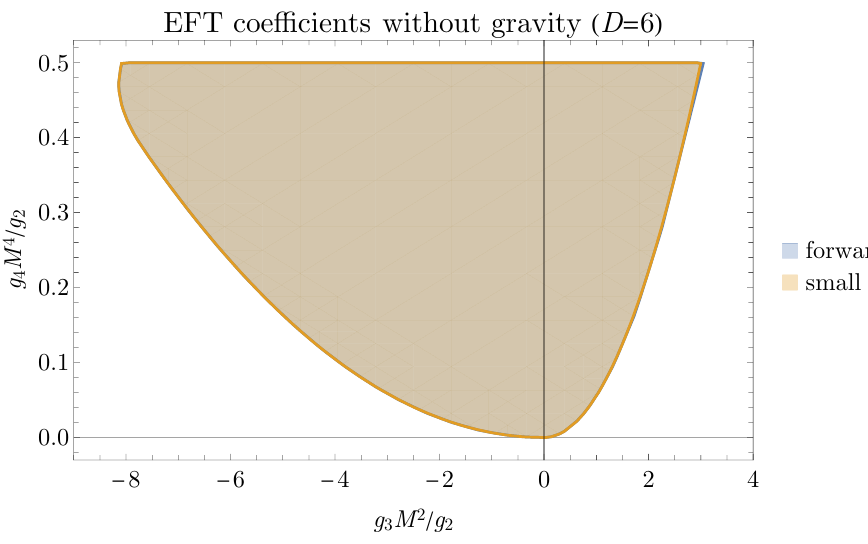
Figure 3 . Allowed region for g 3 and g 4 in a non-gravitational theory in D = 6 dimensions, with heavy mass scale M . We show results using two different methods: the blue region uses derivatives around the forward limit as in [11] (with a 33-dimensional space of functionals), while the yellow region uses small impact parameter wavepackets (built from the 17-dimensional space of functionals listed in table 2, together with C 4 ,u =0 ). The two regions are essentially identical and appear overlapping in the plot. We give more details on our numerical computations in appendix A.